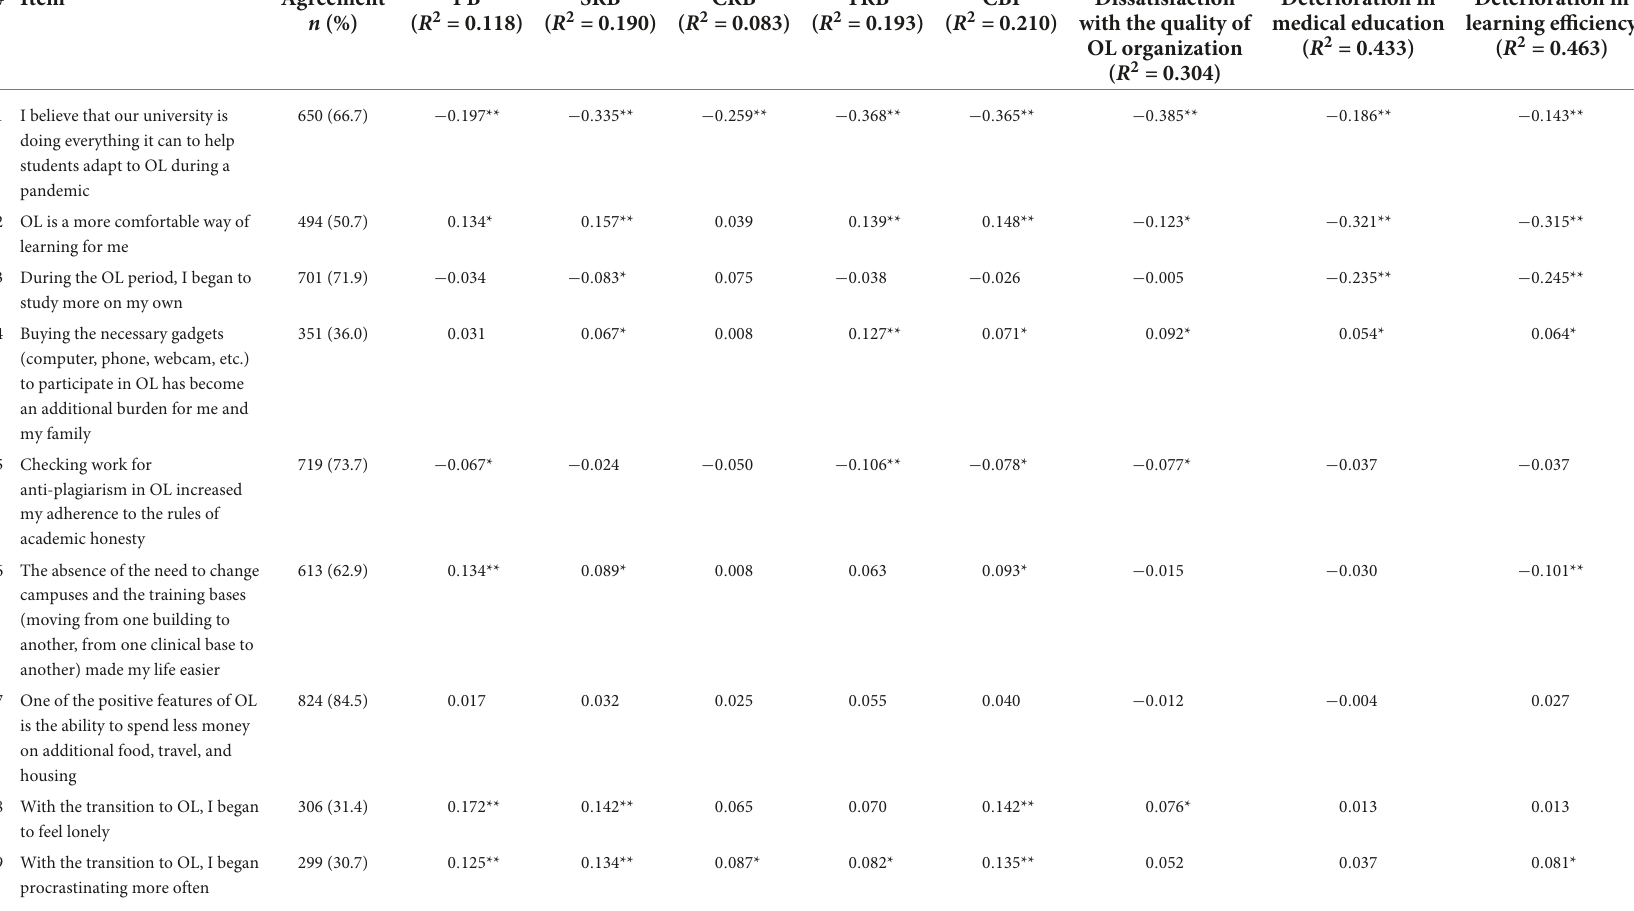
TABLE 3 The degree of students’ agreement with statements about OL during the COVID-19 pandemic and their association with burnout, dissatisfaction with the quality of OL organization, and deterioration in medical education and learning efficiency on linear regression analysis ( N = 975). #